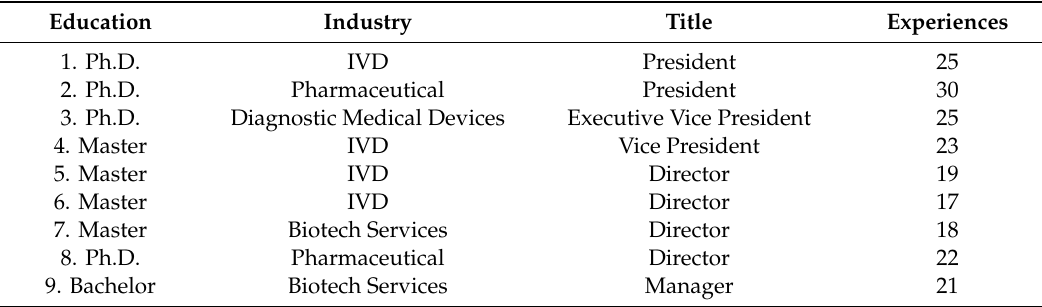
Table 2. Experts’